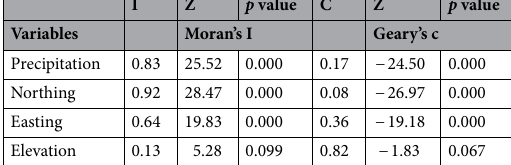
Table 3. Measures of global spatial